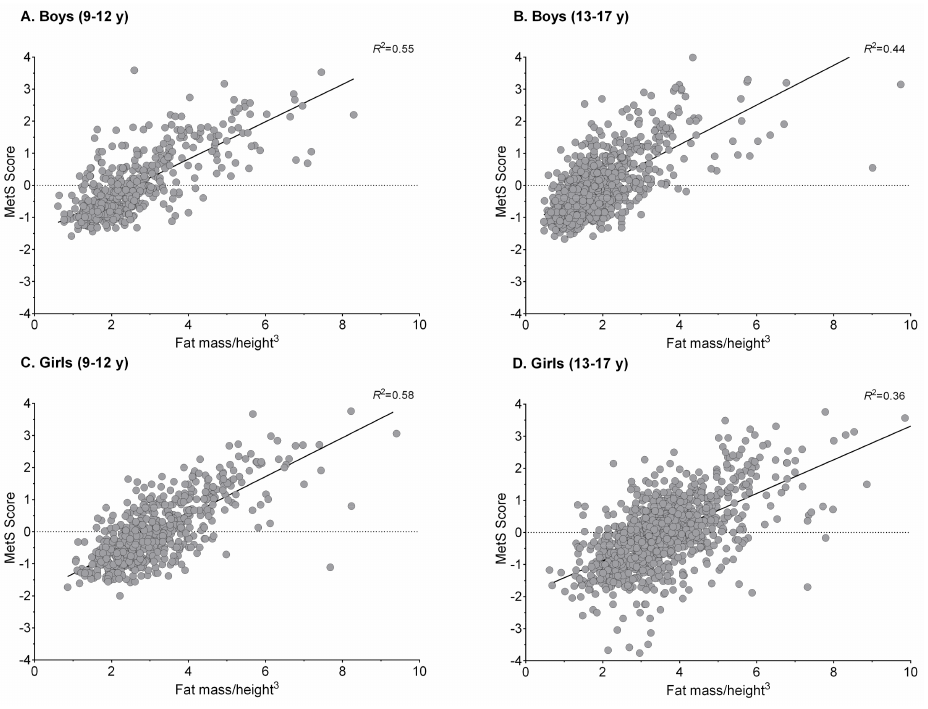
Adolescents 13–17 years ( n = 1830) BMI